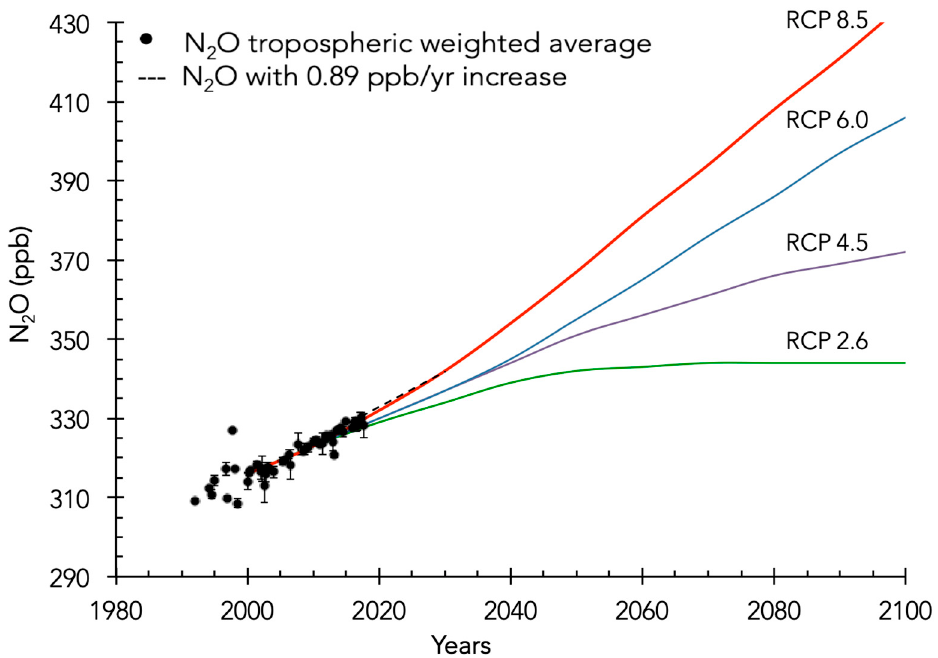
Figure 8. Global tropospheric N 2 O VMR (600–400 hPa) versus years from measurements (weighted average of aircraft and balloon measurements) with error bars representing standard deviation. The dashed line represents the N 2 O VMR with an increase of 0.89 ppb/yr. The colored lines represent the N 2 O VMR according to RCP scenarios [60].